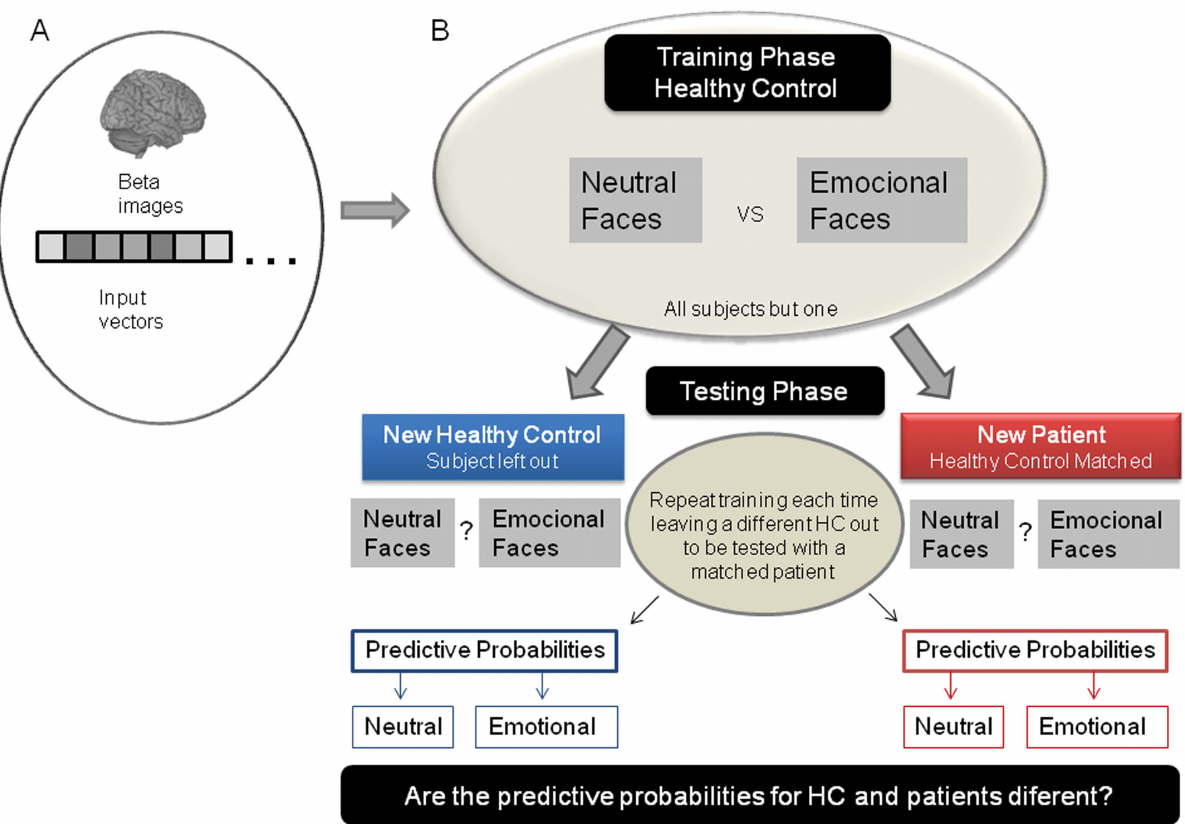
Figure 1. Summary of the pattern recognition analyses. (A) Feature Extraction: the beta images were transformed into an input vector. (B) New pattern recognition framework: we first trained the classifier using data from all but one healthy control subject (by a leave-one-out procedure) to discriminate between brain patterns of activation to emotional (100% sad or 100% happy) from neutral faces. We then tested the classifier using data from the healthy control left out and a gender and age matched depressed patient. Finally, we compared the predictive probabilities between healthy controls and depressed patients.